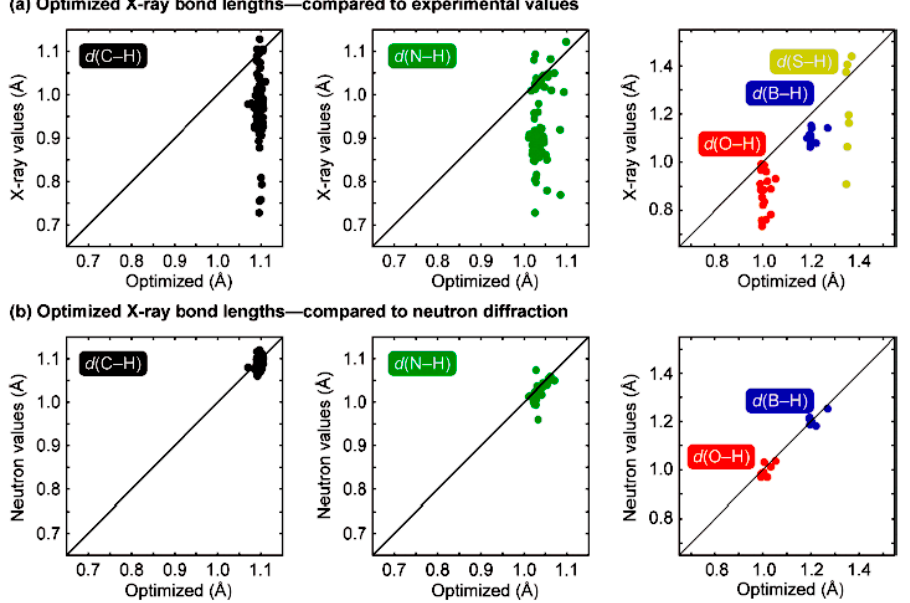
Figure 1. Bond lengths of the investigated structures. ( a ) X-ray determined values (vertical axis) plotted against quantum-chemically optimized ones (horizontal axis); ( b ) Quantum-chemically optimized values (horizontal axis) vs. the available neutron diffraction data. Covalent C–H (left), N–H (middle), O–H, S–H, and B–H (right) bond lengths are considered. Reprinted, with permission, from [24]. Copyright 2012, by The American Chemical Society.